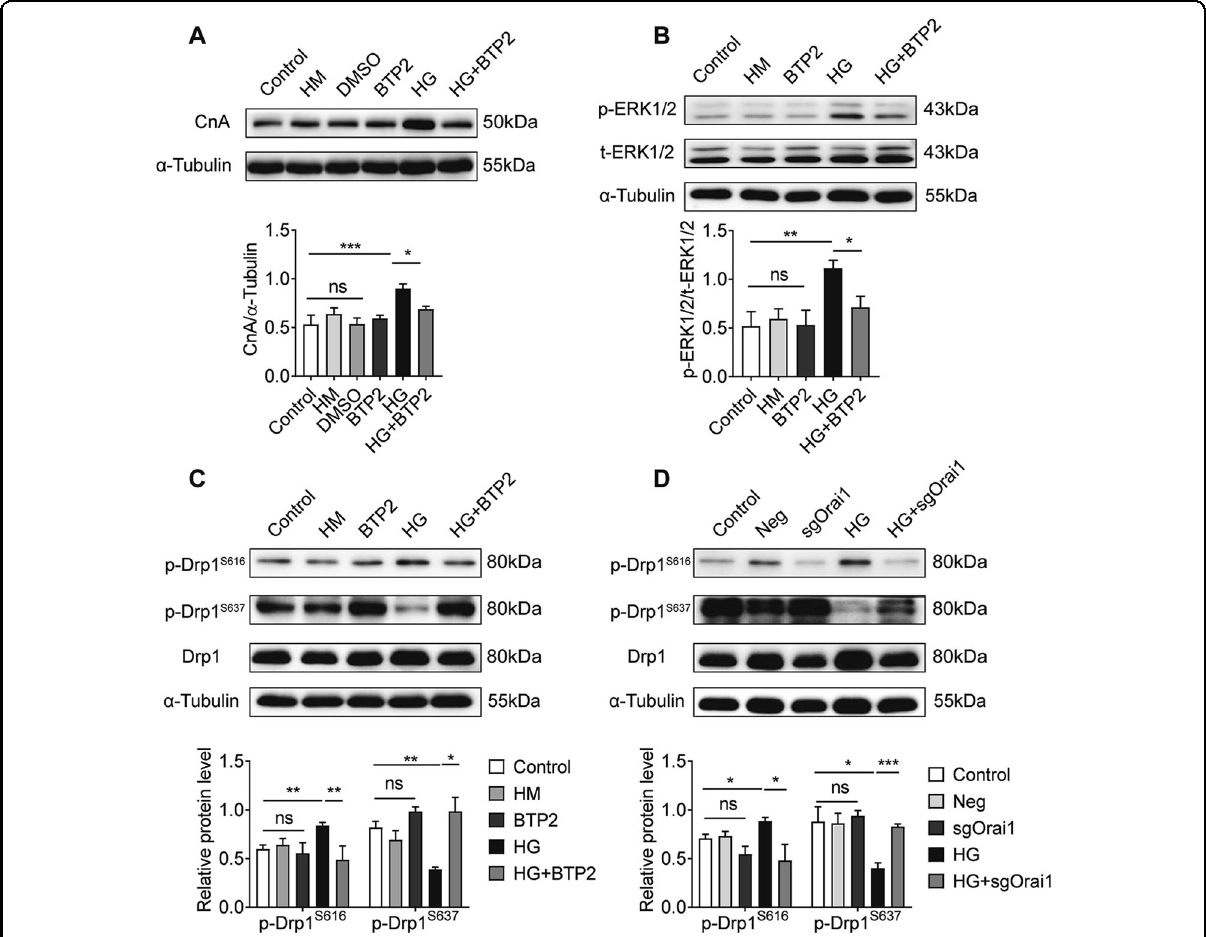
Fig. 6 Orai1 might contribute to HG-induced cardiomyocyte hypertrophy via activation of CnA, ERK-Drp1 pathways. A Changes in CnA levels in NRCMs treated with 10 μ M BTP2 ( n = 4). B Changes of p-ERK1/2 and total ERK1/2 protein levels in NRCMs treated with BTP2 10 μ M ( n = 3). C Western blotting images and summarized data showing p-Drp1 S616 ( n = 4) and p-Drp1 S637 ( n = 3) protein levels in NRCMs treated with 10 μ M BTP2. D Changes of p-Drp1 S616 ( n = 4) and p-Drp1 S637 ( n = 4) levels in NRCMs infected with sgOrai1 at 80 MOI for 72 h. The protein levels of phospho-Drp1 (S616/S637) were normalized by total Drp1. Data are shown as mean ± SEM. * P < 0.05, ** P < 0.01, and *** P < 0.001; n.s: no signi fi cant statistical